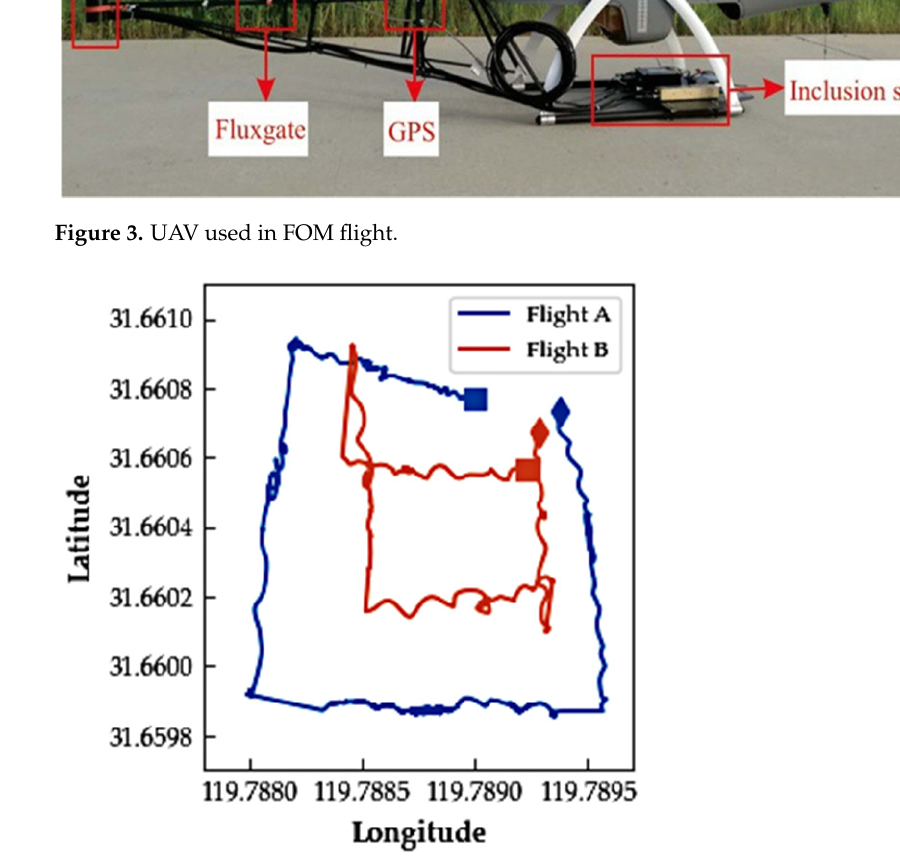
Figure 4. The FOM flight path. The square represents the beginning of the flight, and the diamond represents the end of the flight.